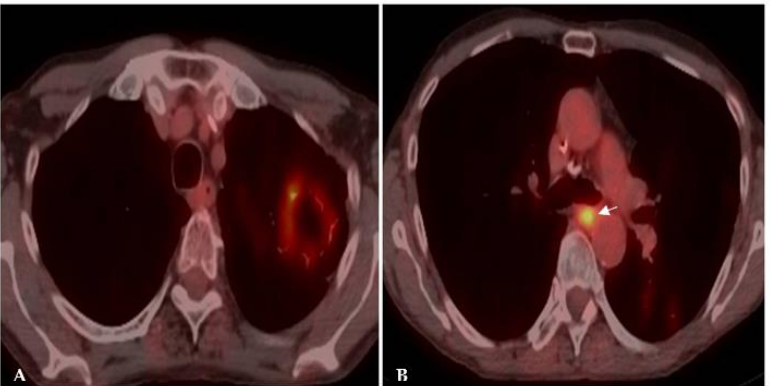
Figure 5. Chronic histoplasmosis infection. FDG PET/CT images show higher FDG activity in a mediastinal draining lymph node (arrow in ( B ) than in the left upper lobe cavitary mass ( A ). The flip-flop fungus sign discloses the benign granulomatous nature of the disease.